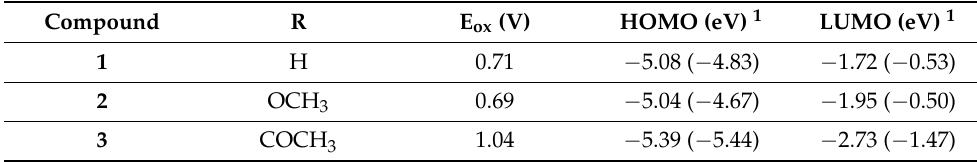
Table 1. Main electrochemical properties of compounds 1 – 3